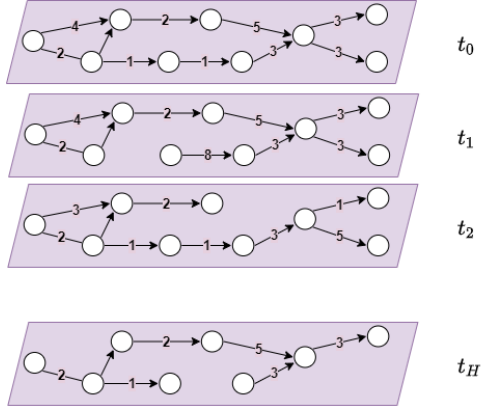
Figure 2. Space–time